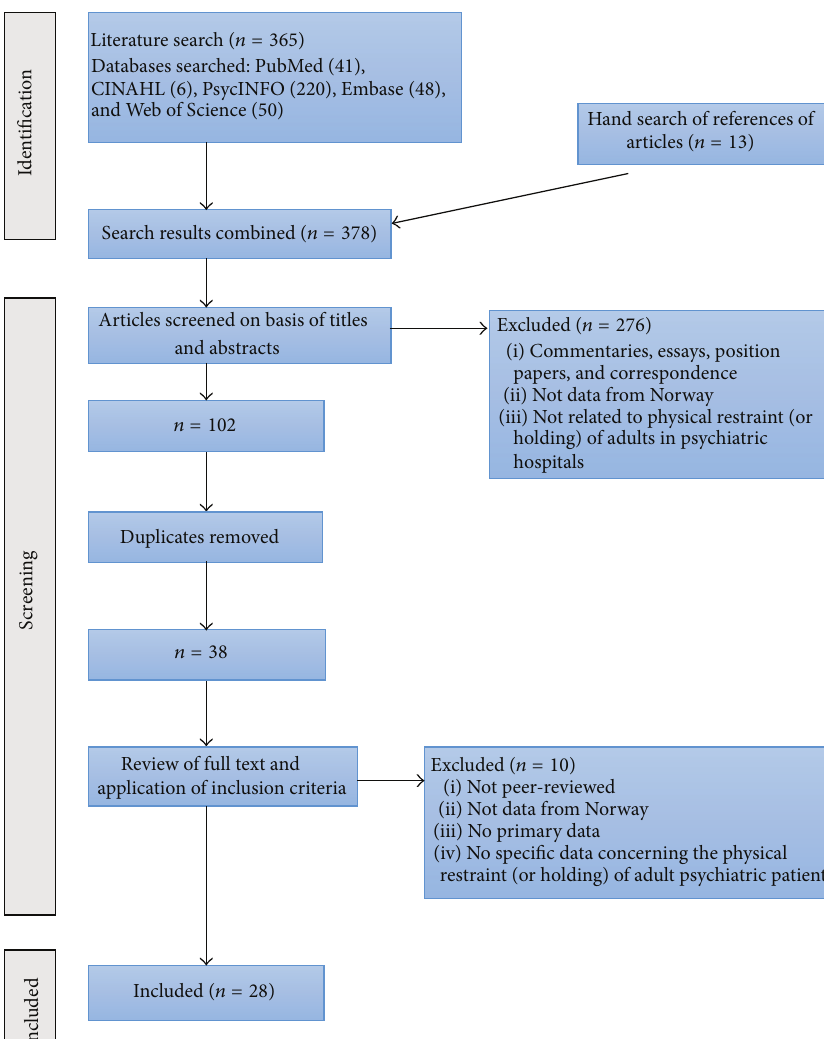
Figure 1: Process for selection of studies included in the